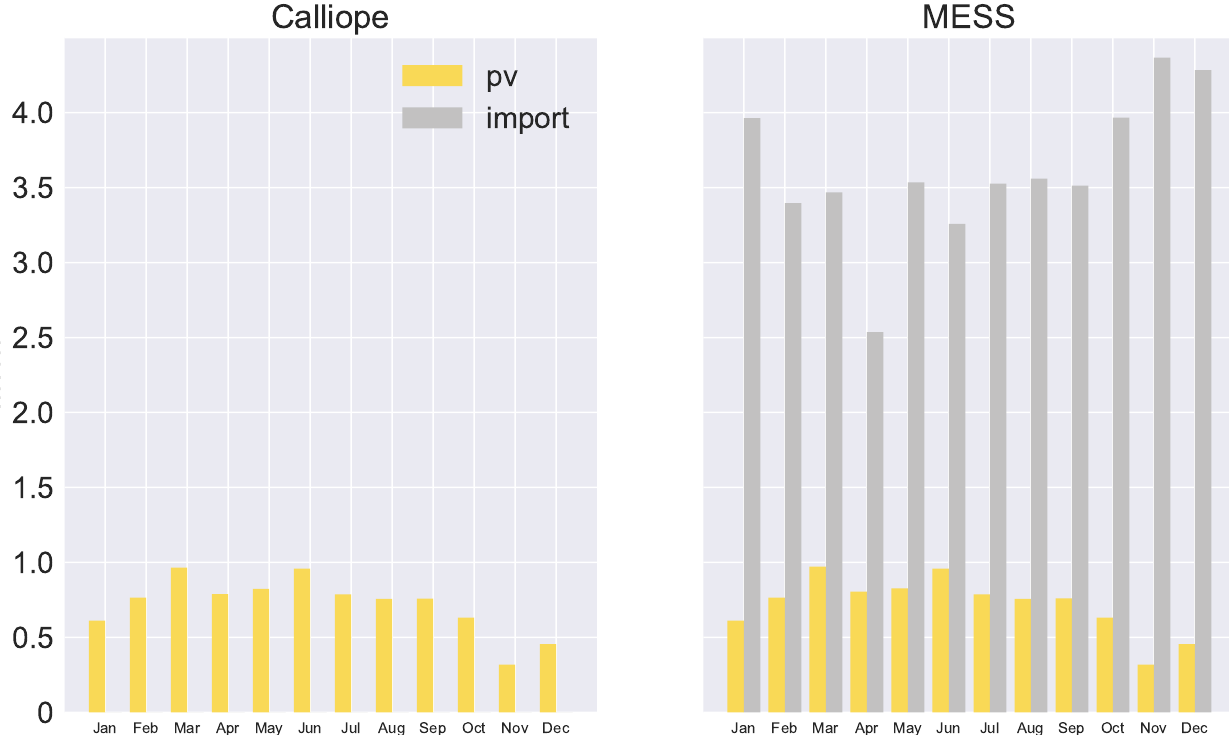
Figure A2. Monthly electricity production per technology source: Location X3—Calliope and MESS